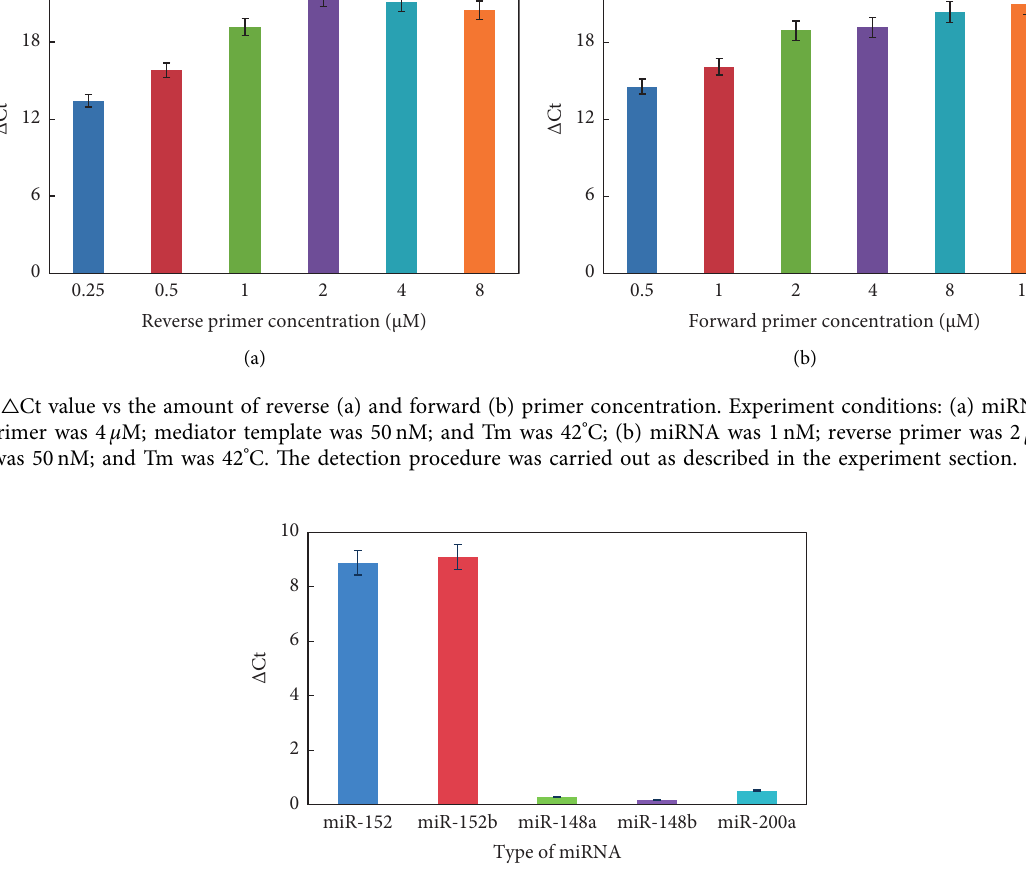
Figure 5: △ Ct value vs different type of miRNA. Experiment conditions: miRNA was 50pM; forward primer was 4 μ M; reverse primer was 2 μ M; mediator template was 50nM; and Tm was 42 ° C. The detection procedure was carried out as described in the experiment